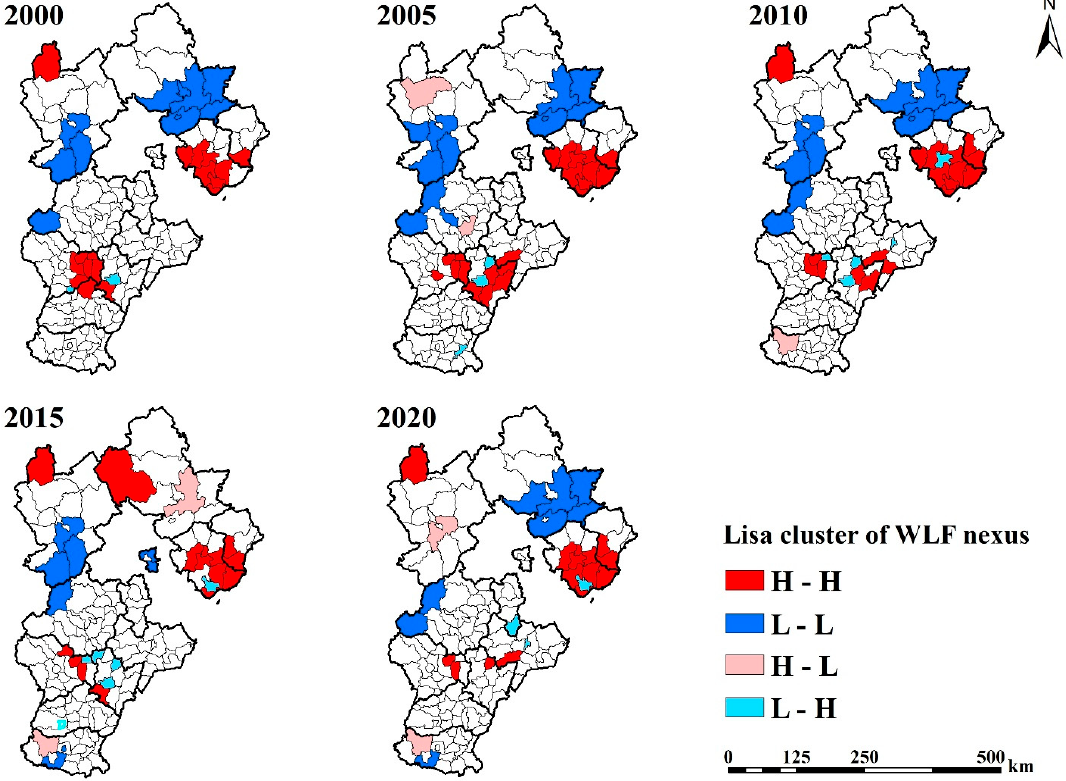
Figure 8. The WLF Nexus System’s Lisa Aggregations map of 151 counties in Hebei Province.